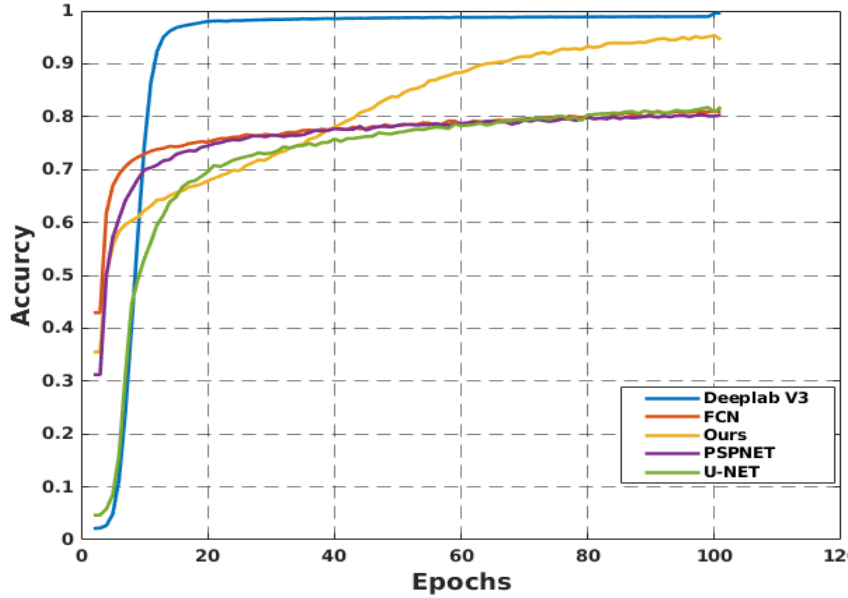
Figure 6. Comparison of the proposed method with baseline methods in terms of accuracy.